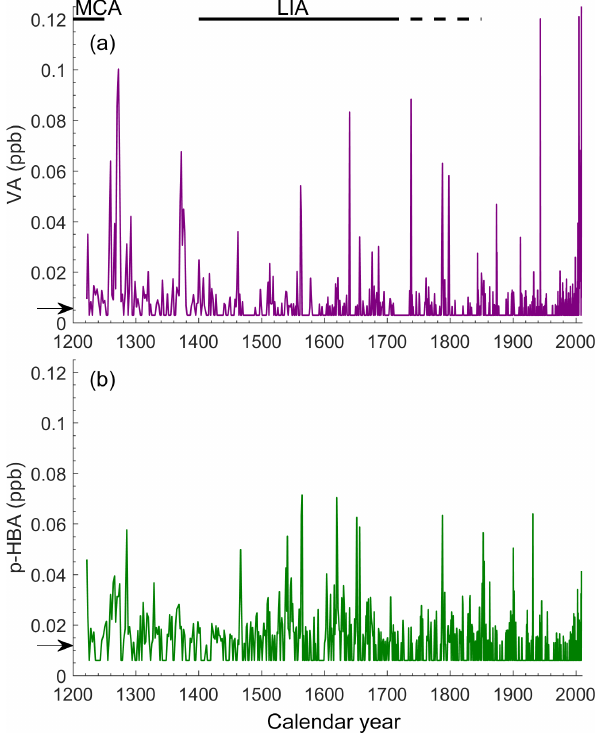
Figure 2. Aromatic acids in the Lomonosovfonna, Svalbard ice core. (a) Vanillic acid, (b) p -hydroxybenzoic acid. Arrows are the detection limits. The black horizontal lines are the Medieval Cli- mate Anomaly (MCA) and the Little Ice Age (LIA) (Mann et al., 2009). The dashed horizontal line is the extended LIA in the Sval- bard region (Divine et al.,